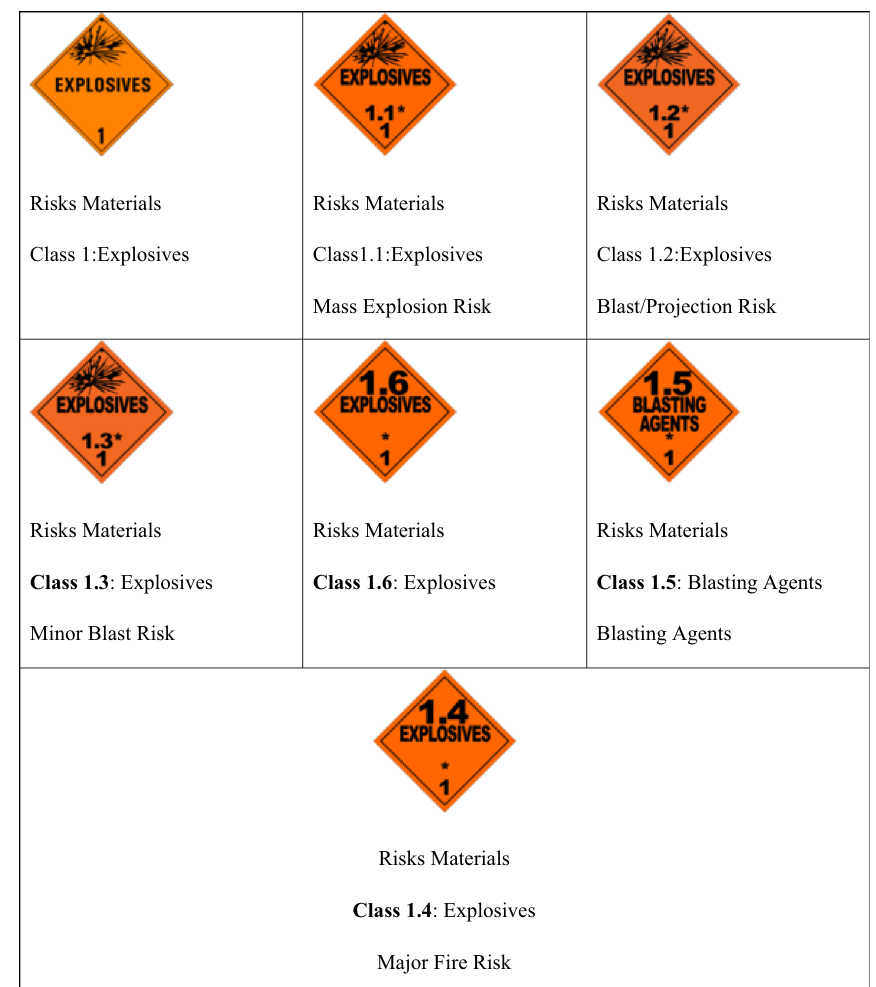
Fig. 1 Extremely insensitive